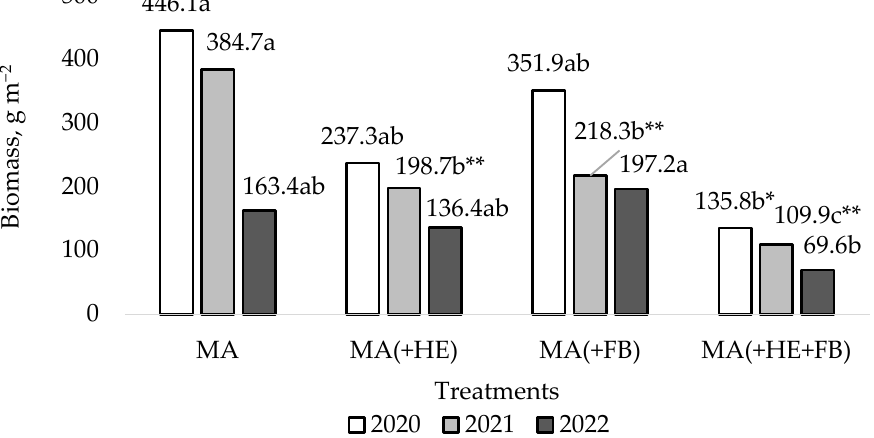
Figure 3. Impact of multi-cropping on maize dried biomass, 2020–2022. MA: maize single-crop (con- trol treatment), MA + HE: maize + hemp, MA + FB: maize + faba bean binary crops, MA + HE + FB: maize + hemp + faba bean ternary-crops. Different letters (a, b, c) within columns of separate vegeta- tive season show significant difference between treatments at p ≤ 0.05; * significant differences from MA at p ≤ 0.05; ** at p ≤ 0.01.